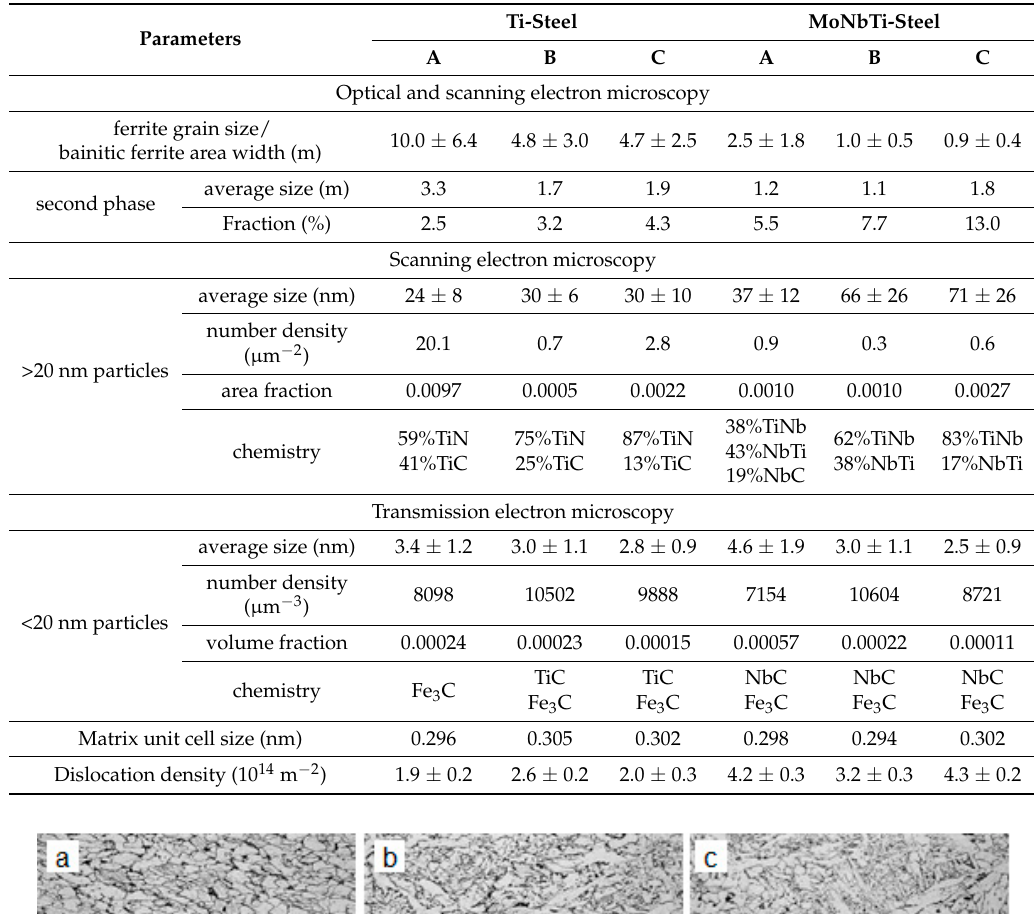
Table 1. Microstructural parameters in the studied steels.